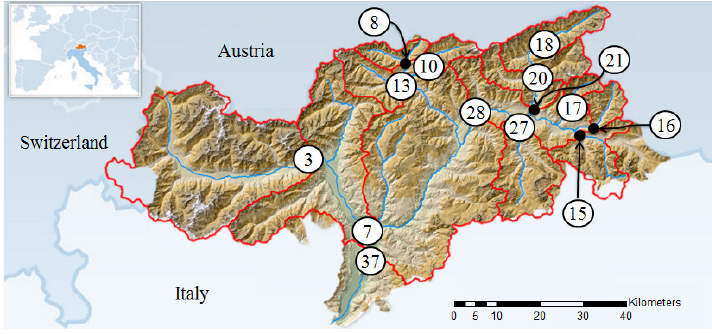
Figure 1. South Tyrol in northern Italy, location of the analyzed catchments.